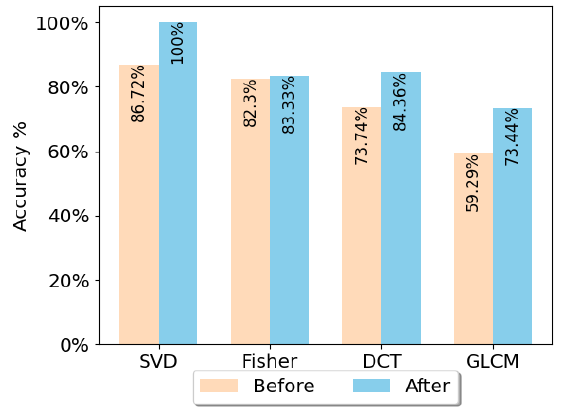
Figure 12. Comparison of the classification performances before denoising and after applying the DFT-based periodic noise removal algorithm, using different feature extraction methods and LR classification. The Coventry-2018 large-layout data (15-class problem) of Sensor-1 was